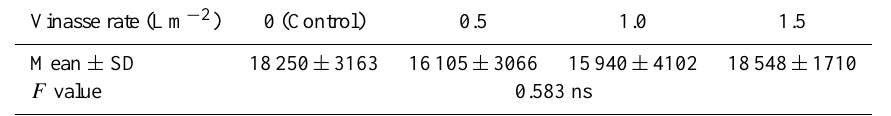
Table 3. Mean and standard deviation (Mean ± SD) of runoff volume (mL) under different vinasse treatments in the study 0.25m 2 plots.